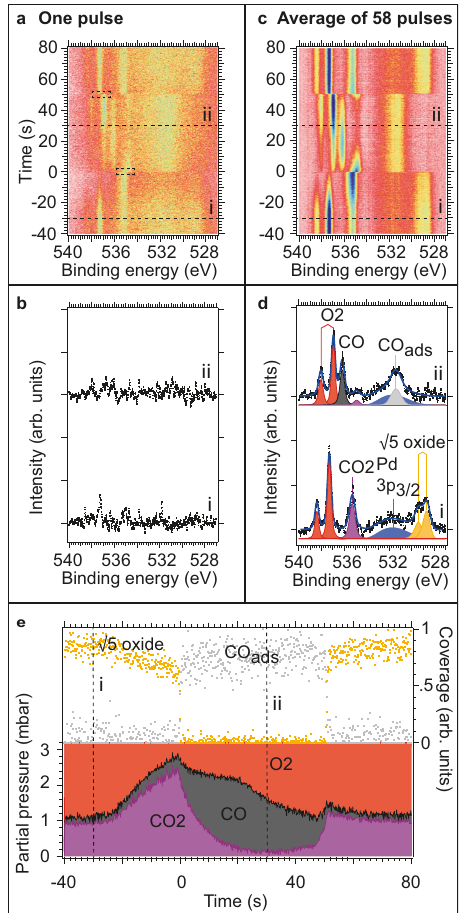
Fig. 1 Analysis of time-resolved O 1s data recorded at 3.2 mbar before and after event-averaging. a , c Image plots of time-resolved O 1s data acquired with a photon energy of 650 eV before and after event-averaging 58 pulses. b , d Single spectra recorded along the dotted lines i and ii in panels ( a and c ) and the curve fi tting and peak assignment for the event- averaged data. e Partial pressures, √ 5 oxide, and CO coverage as obtained by curve fi tting all spectra in panel ( c ). Partial pressures are shown on vertically stacked y -axises — i.e., at t = − 40 s the partial pressure of CO is zero. The following colours and markers are used in panels ( d , e ): O 2 (g) red, CO(g) grey, CO 2 (g) purple, Pd 3p 3/2 blue, CO ads light grey squares, and √ 5 oxide intensity orange